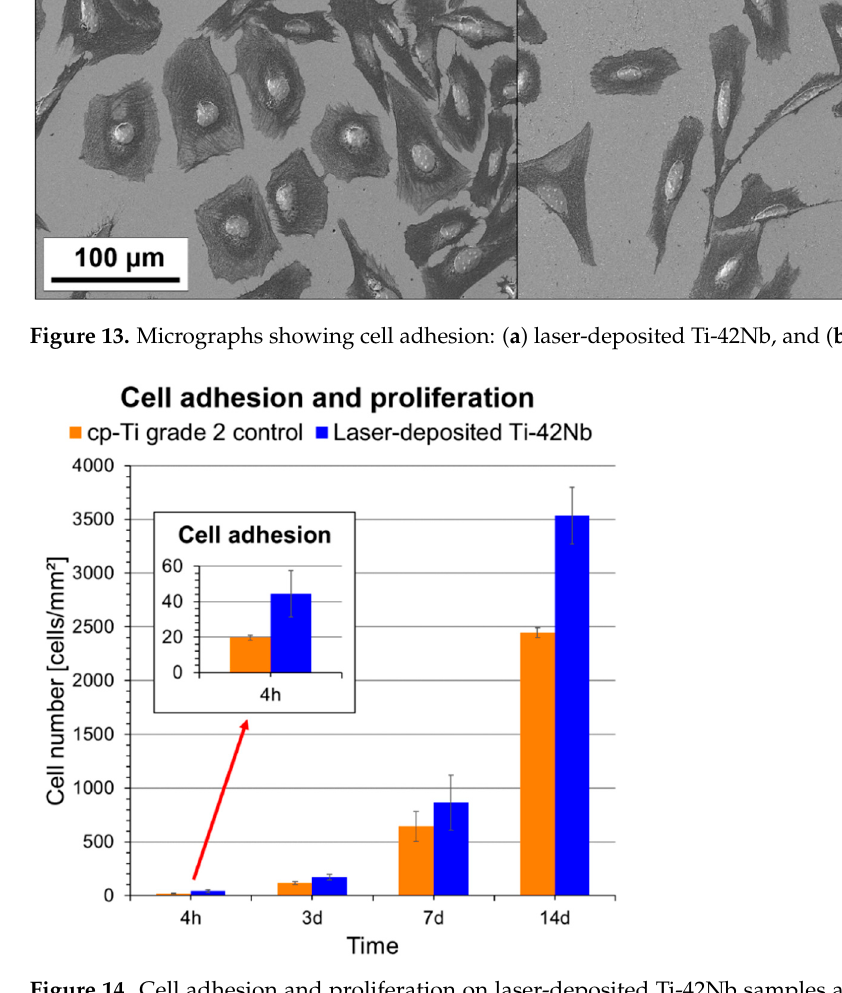
Figure 14. Cell adhesion and proliferation on laser-deposited Ti-42Nb samples and cp-Ti grade 2. The inset graphic shows the adhesion results. Error bars represent standard deviation.